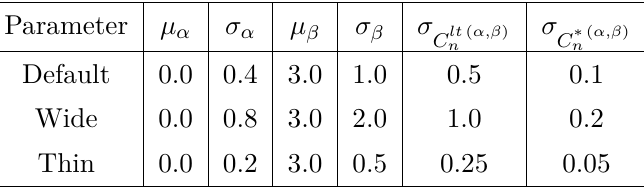
(cid:0) (cid:1) ν, z 2 is denoted by σ lt ( α,β ) , C n